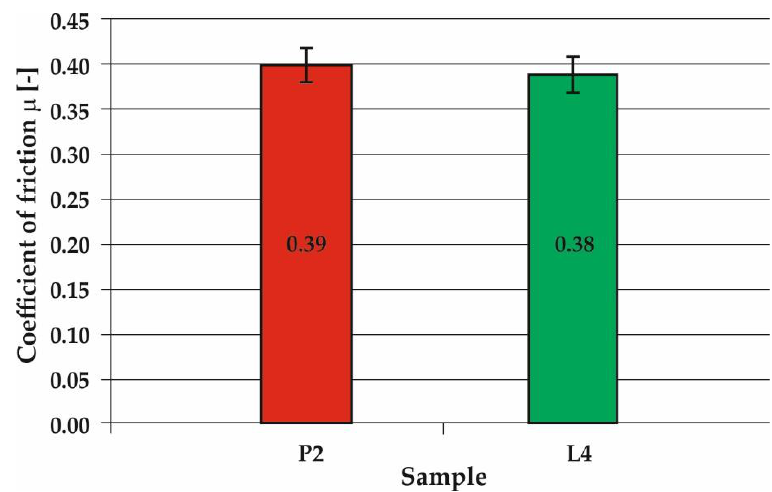
Figure 9. Coefficient of friction for Inconel 625 superalloy layer obtained in the process of plasma powder transferred arc surfacing (sample P2) and of laser surfacing (sample L4). Materials 2020 , 12 , x FOR PEER REVIEW